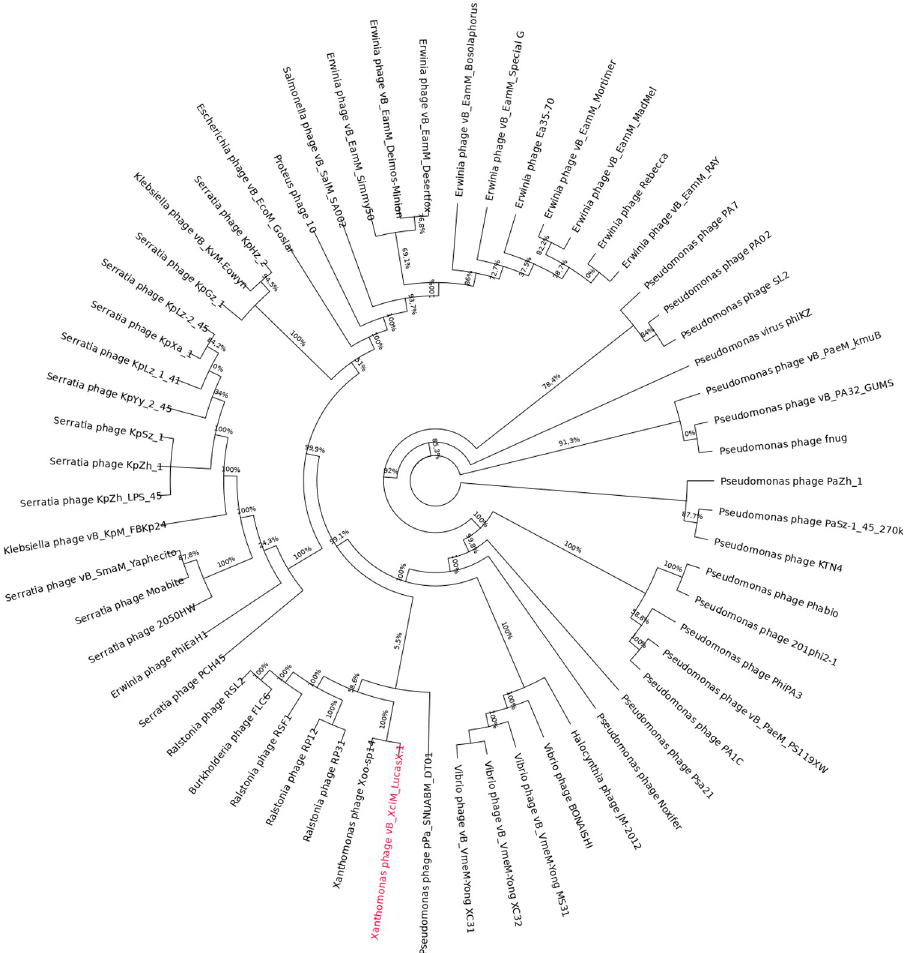
Fig 5. Tree calculated using the core of protein clusters of vB_XciM_LucasX and related phages. The proteome- based comparison places vB_XciM_LucasX (in red) close to other phages of the Myoviridae family. The figure was produced using the FastTree tool for maximum likelihood calculation and the FigTree visualization